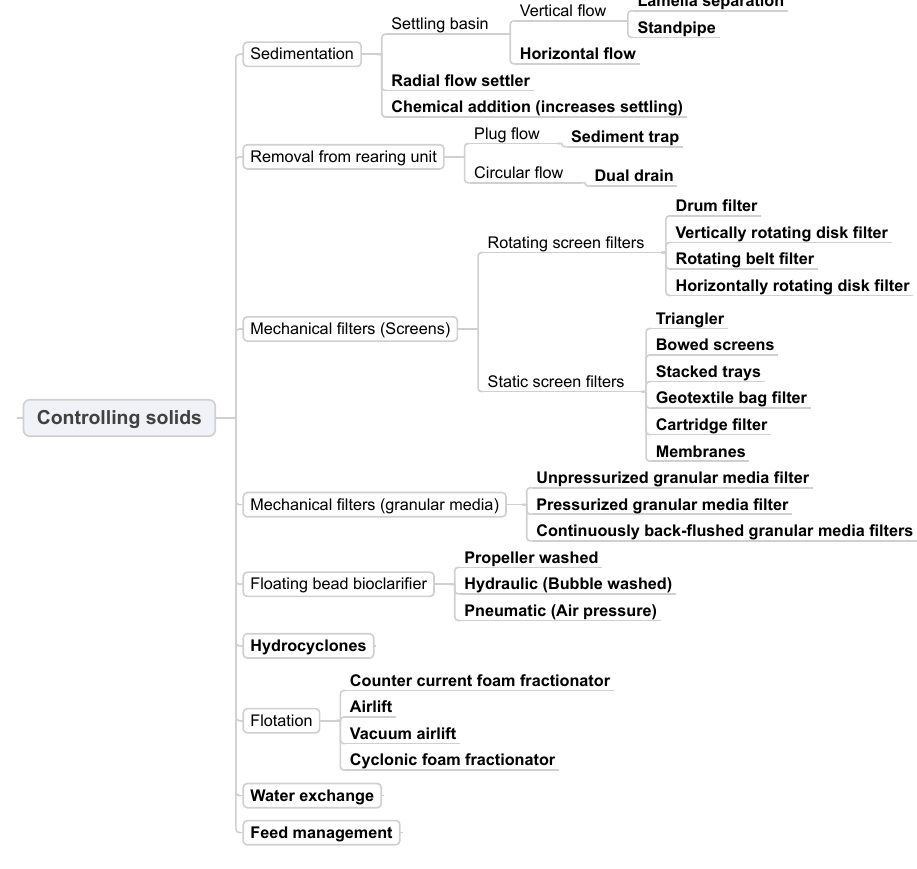
Figure 2. Taxonomy: controlling